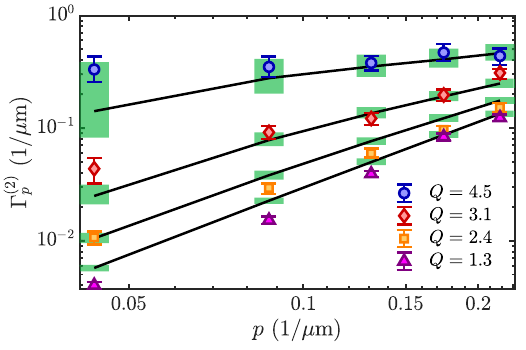
FIG. 9. Experimental 1PI two-point function. The four different measurements correspond to Q ¼ 4 . 5 (blue circles), 3.1 (red diamonds), 2.4 (orange squares), and 1.3 (purple triangles). The error bars represent the 80% confidence intervals obtained using bootstrapping. We see good agreement with the theory prediction from the sine-Gordon model in thermal equilibrium calculated for 10 6 numerical realisations (black solid lines). The height of the green bars indicates the 80% confidence interval for the numeri- cal predictions considering the finite experimental sample size. Note that all uncertainty comes from the finite sample size; no uncertainty in the parameters λ and Q is assumed. The width of T the bars is chosen